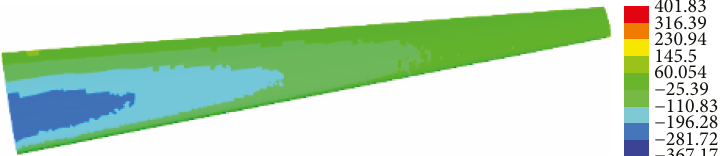
Figure 15: Stress cloud diagram of the upper wing with the layer sequence being [0/45/90/-45/0]